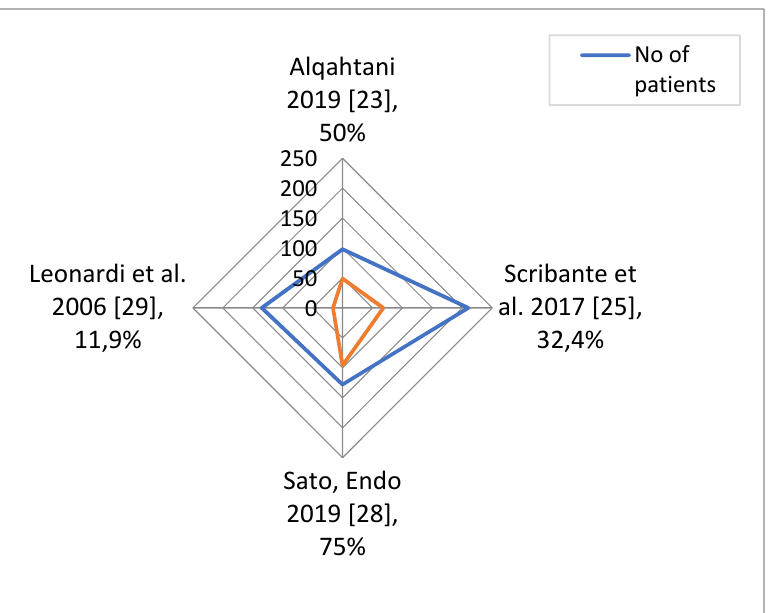
Figure 3. Total number of patients included in each study, and numbers and percentages of patients with hypodontia.